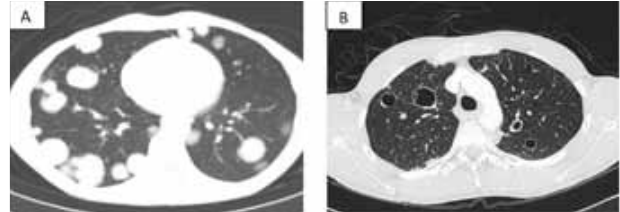
Fig. 1. Chest computed tomography of metastatic testicular cancer. (A) Pre- treatment: Note bilateral lung nodules and masses. (B) Post-treatment: Note thin-walled cystic